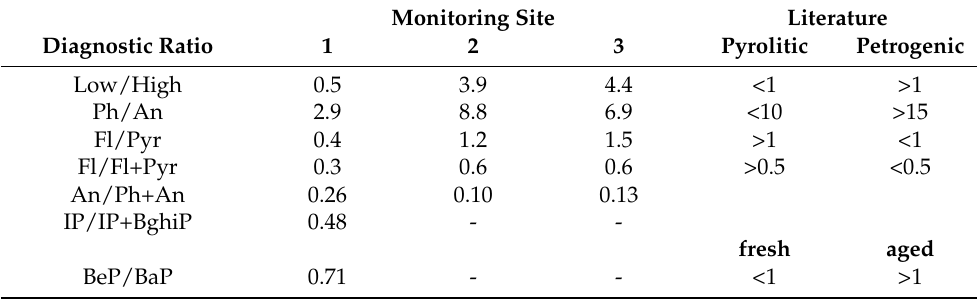
Table 5. –PAH diagnostic ratio of the three monitoring bee